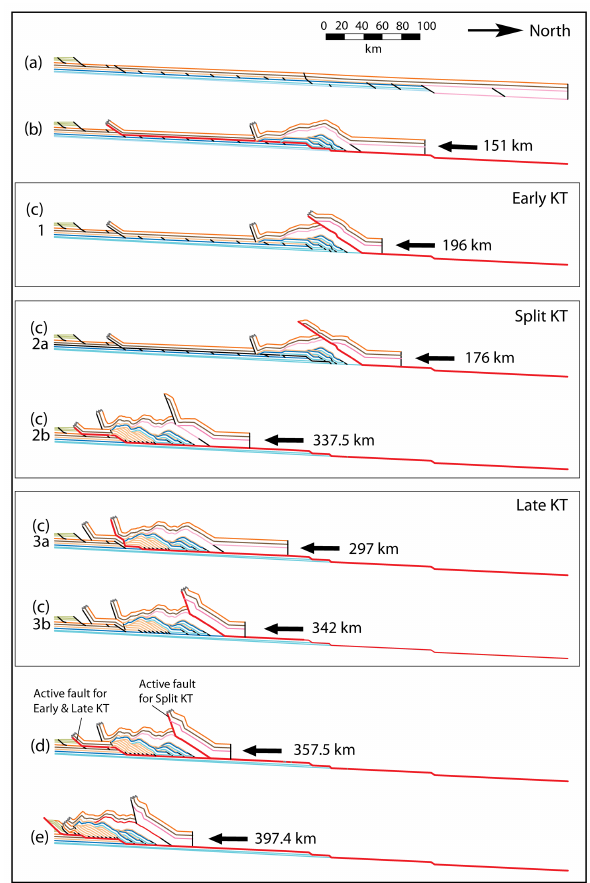
Figure 3. Sequential kinematic reconstruction of the Trashigang cross section depicting three kinematic scenarios of out-of- sequence thrusting tested in this study. Net slip amounts are shown for each panel. (a) The restored section used in the kinematic model; (b) deformation along the MCT and ST, including duplexing of the lower LH; (c) 1: KT motion prior to upper LH duplexing (Early KT), 2: KT motion before and after upper LH duplexing (Split KT), 3: KT motion after seven out of eight horses of upper LH duplex have been deformed (Late KT); (d) completion of out-of-sequence thrusting and upper LH duplexing. Note that the most recent active fault in this step for Split KT varies; (e) deformation along MBT and